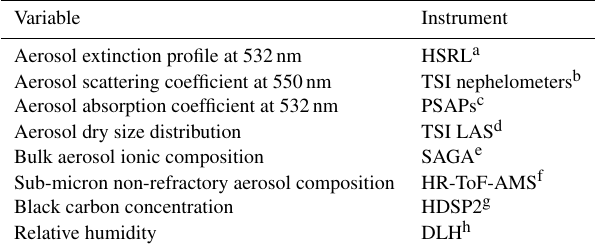
Table 1. Surface site observations used in this work (2016). Variable